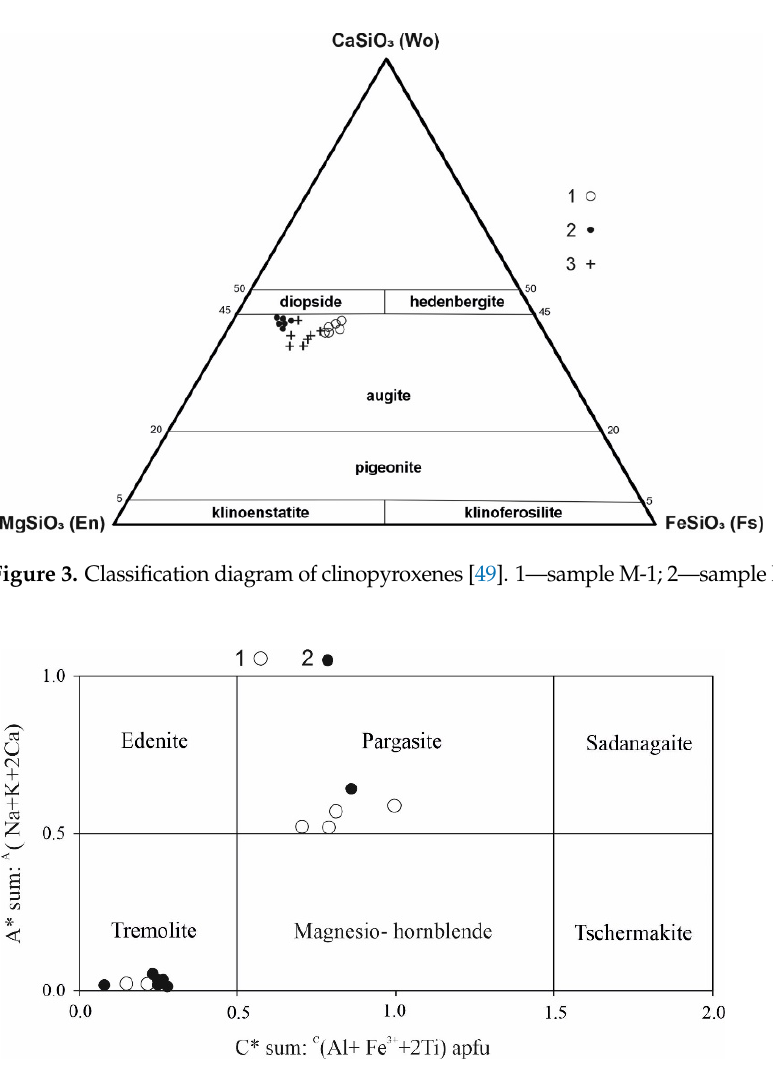
Figure 4. The classification diagram of amphiboles, according Hawthorne et al., [50]. 1—sample M-1; 2—sample M-8.